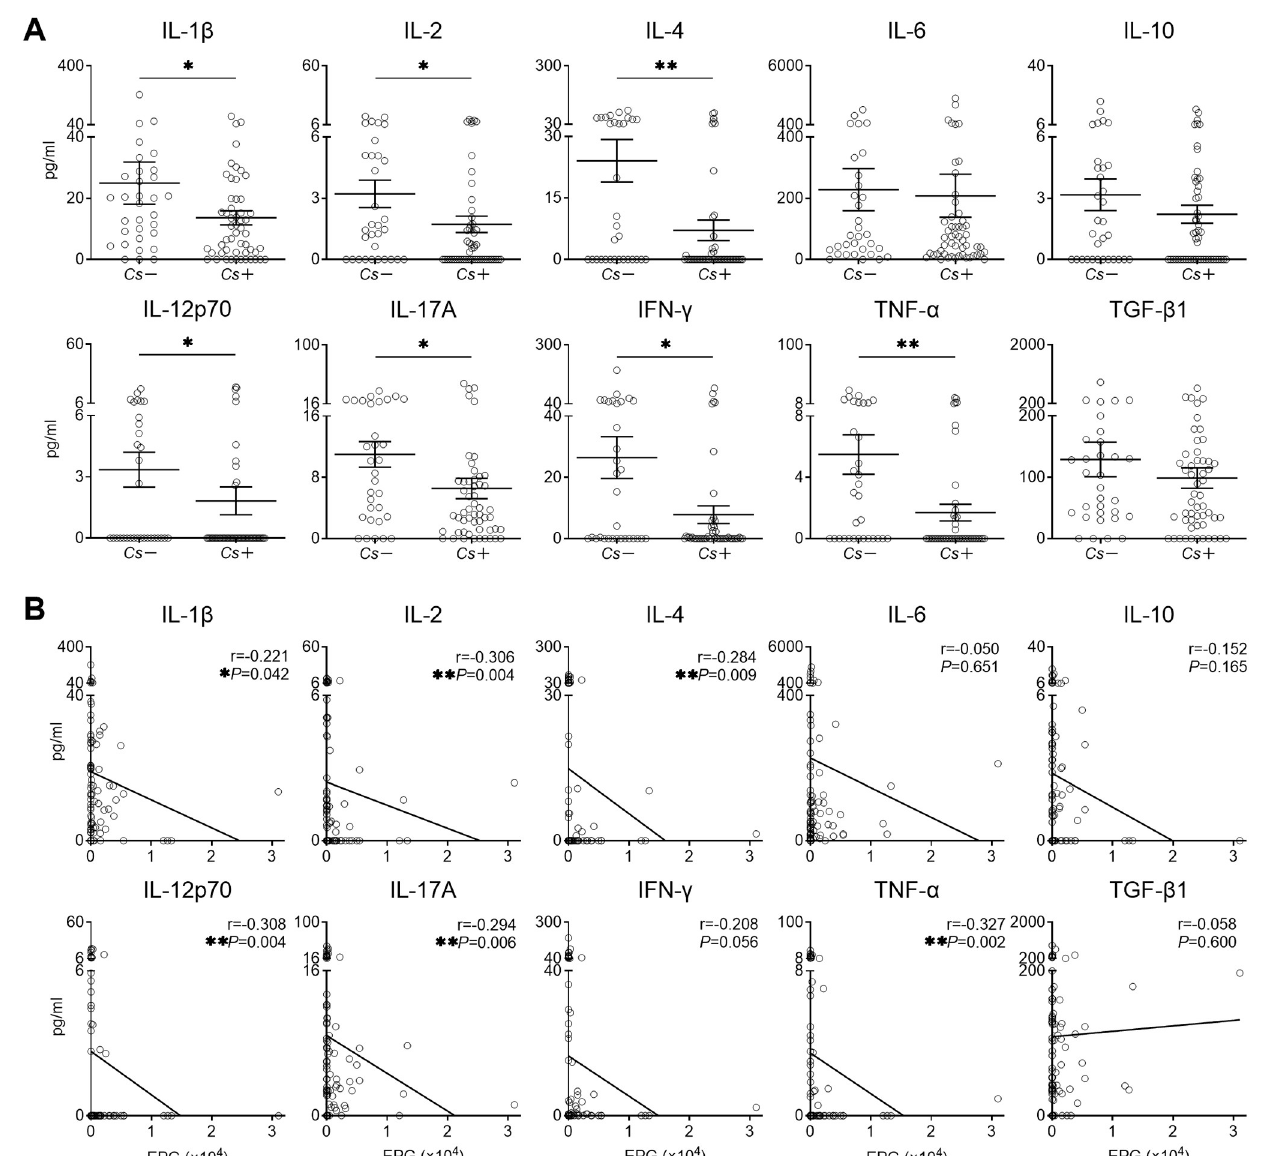
Fig 6. Serum levels of cytokines in Cs - and Cs + individuals without hepatobiliary diseases. (A) Serum levels of IL-1 β , IL-2, IL-4, IL-6, IL-10, IL-12p70, IL-17A, IFN- γ , TNF- α and TGF- β 1 in Cs - individuals (n = 32) and Cs + individuals (n = 53) without hepatobiliary diseases. (B) Spearman’s correlation analysis between EPG and serum levels of IL-1 β , IL-2, IL-4, IL-6, IL-10, IL-12p70, IL-17A, IFN- γ , TNF- α , and TGF- β 1 (n = 85). Cs : C . sinensis infection, EPG: eggs per gram of feces. The data were shown as the mean ± s.e.m., � P < 0.05, �� P < 0.01, Mann-Whitney U test in (A) , Spearman’s correlation test in (B)